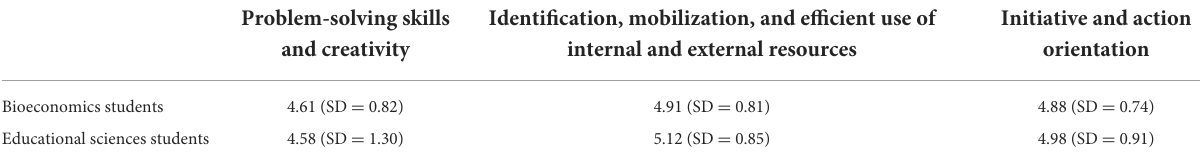
TABLE 3 Mean values of educational sciences and bioeconomics students’ self-assessments of entrepreneurship sub-competences.